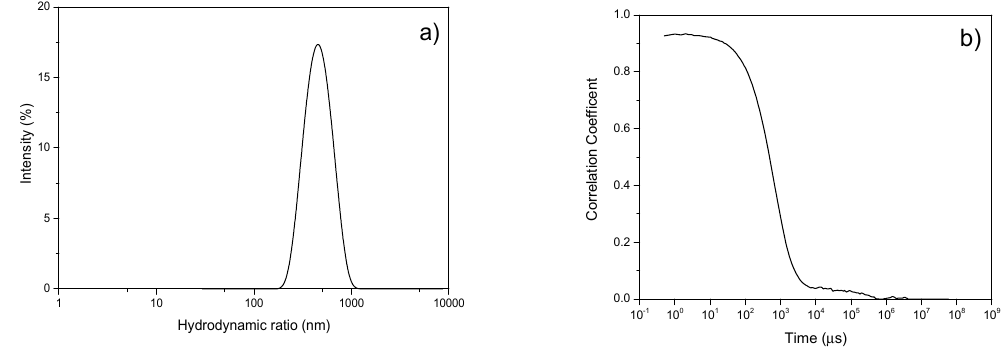
Figure 5. (a ) Dynamic light scattering (DLS) size distribution curve of GNS and ( b ) normalized correlation function of the scattered light intensity of intensity correlation function of the scattered light intensity of GNS.